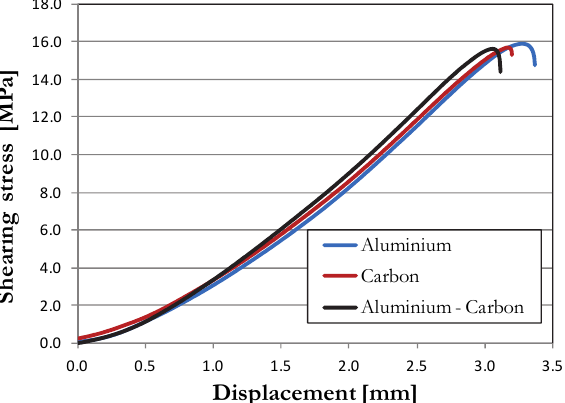
Figure 8: Influence of material combinations for 5 mm adherend